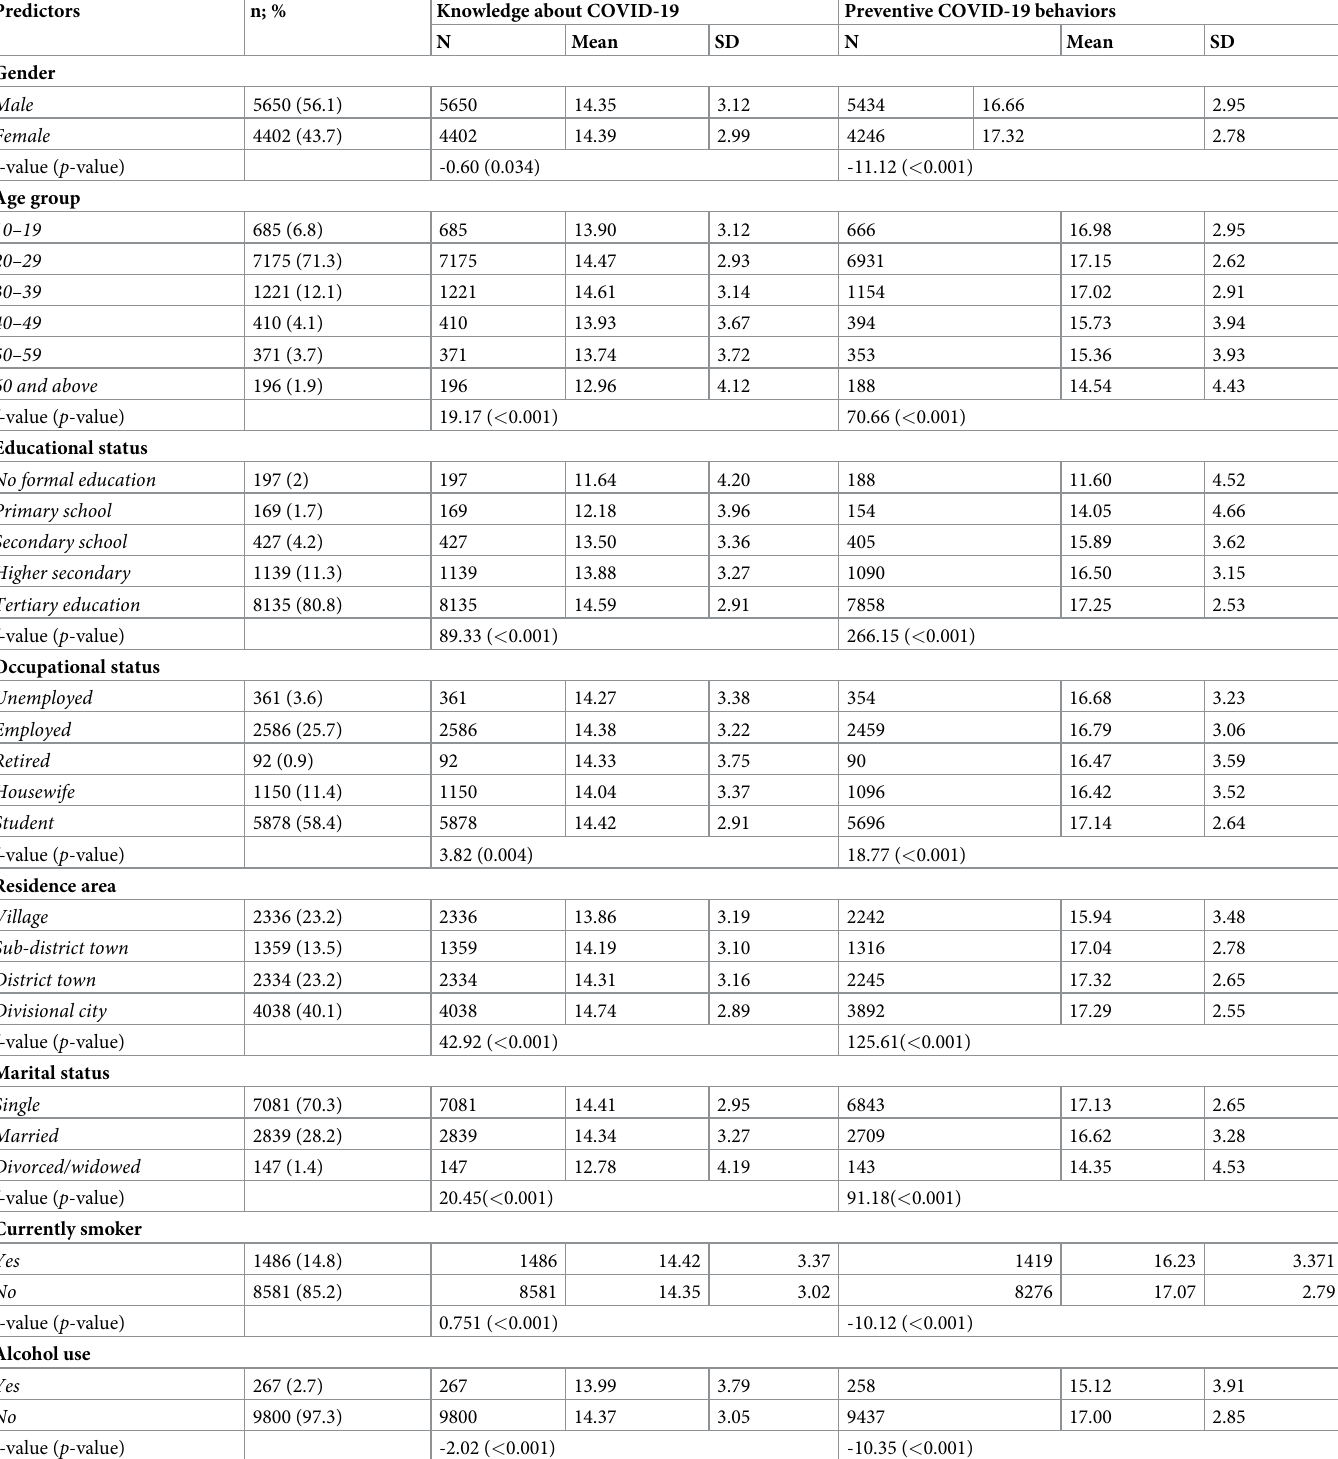
Table 1. Distribution of participant characteristics in respect to knowledge about COVID-19 and preventive COVID-19 behaviors.